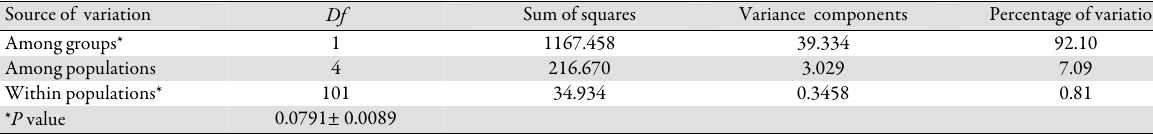
Table 4. Analysis of molecular variance (AMOVA) for the COI sequences in E. tetradactylum . Source of variation Df Sum of squares Variance components Percentage of variation